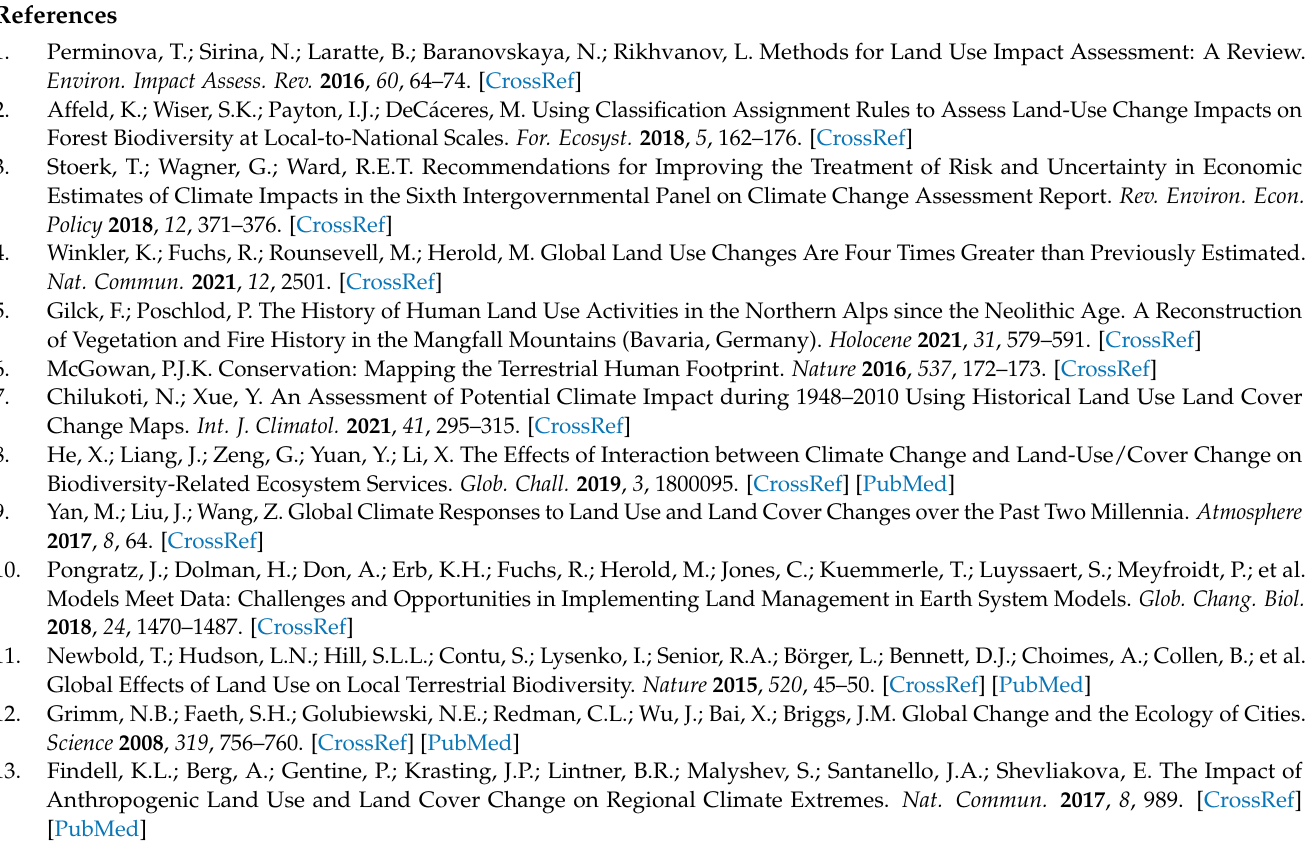
accuracy results. Table S3: Verification of classification accuracy. Table S4: UA and PA of